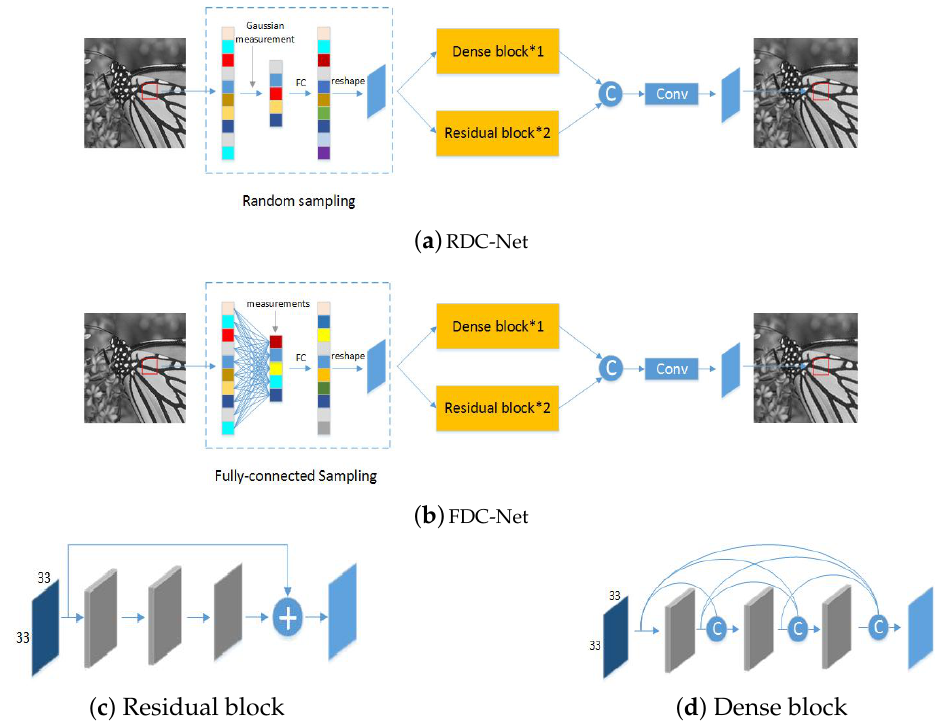
Figure 1. ( a ) The architecture of dual-channel reconstruction network with random measurement matrix (RDC-Net). ( b ) The architecture of dual-channel reconstruction network with fully connected measurement matrix (FDC-Net). ( c ) The structure of residual block. ( d ) The structure of dense